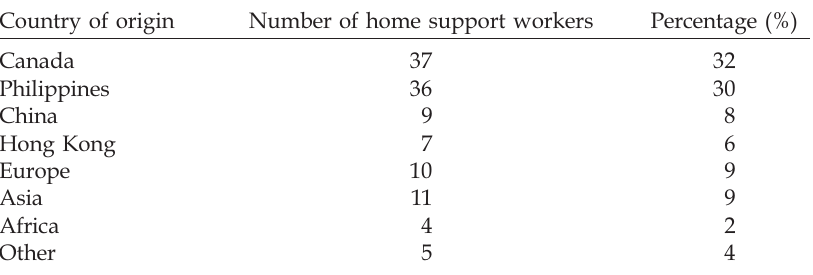
Table 1. Country of birth of home support workers (cid:1) BC inter v iews Country of